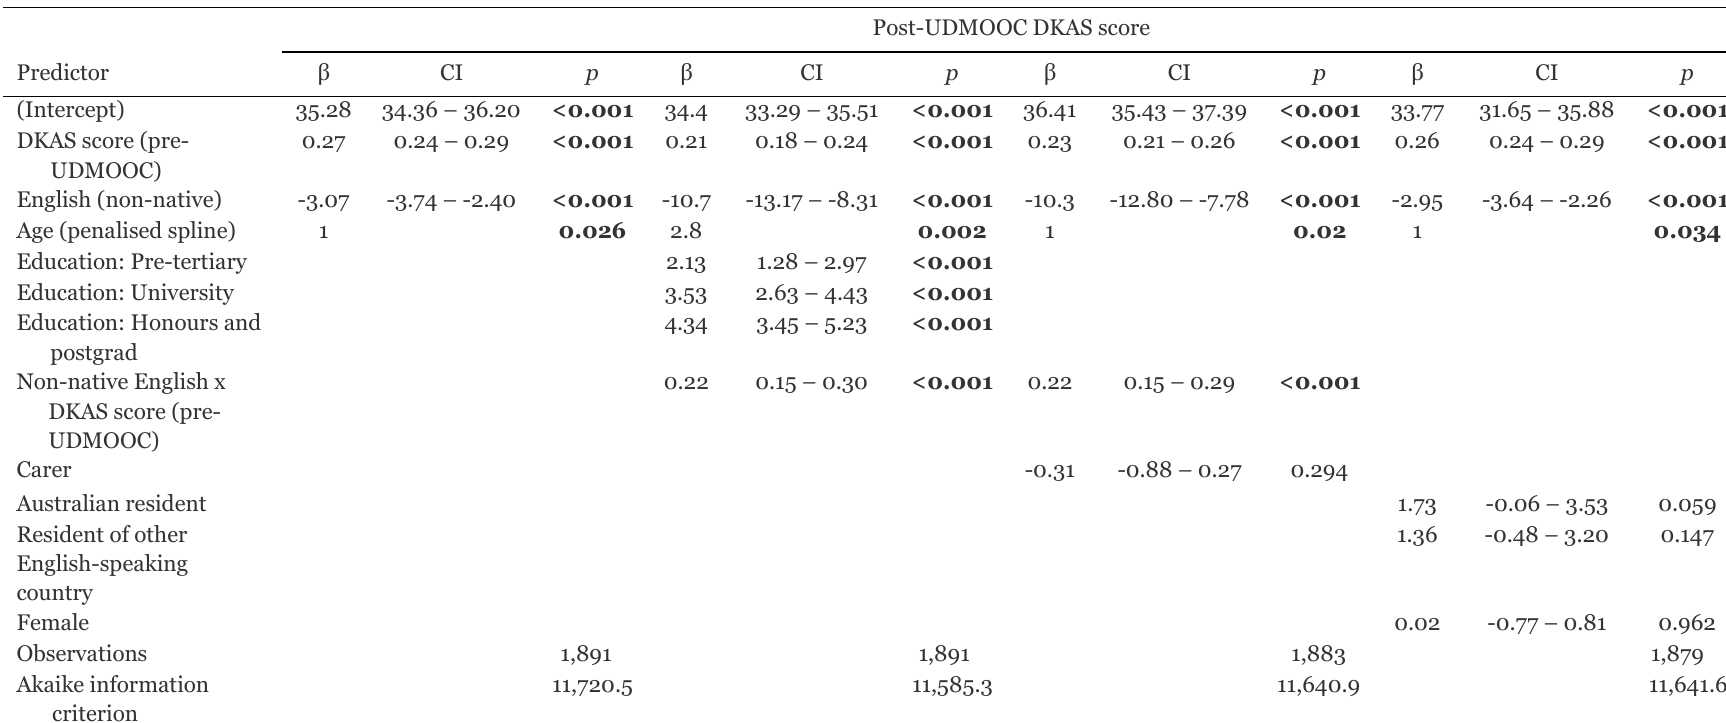
Unstandardized Regression Coefficients with 95% Confidence Intervals for Post-UDMOOC Dementia Knowledge Scores